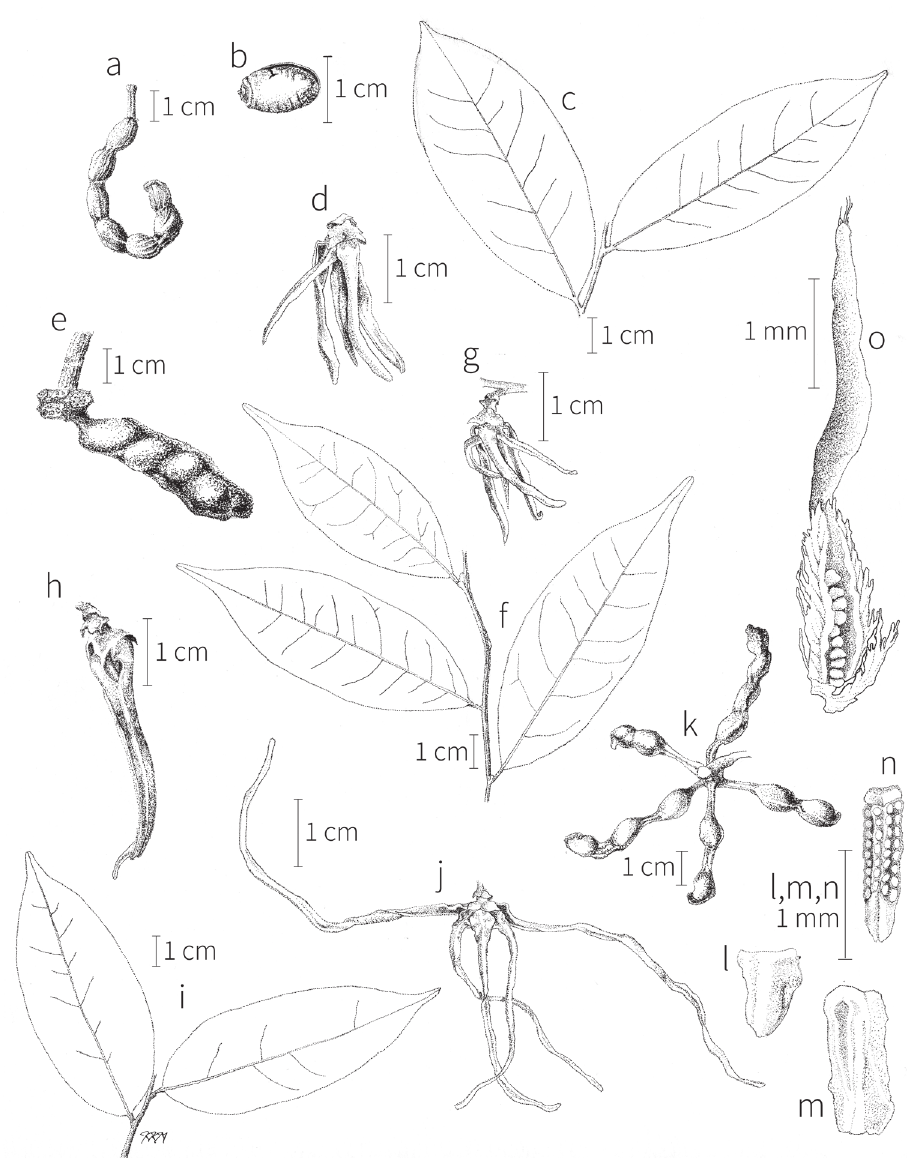
Figure 33. Xylopia unguiculata, X. acutiflora , and X. piratae . A–D, L–O X. unguiculata A Monocarp, lateral view B Seed C Leaves D Flower, lateral view L, M Staminodes, abaxial view N Stamen, abaxial view O Carpel, lateral view with ovary wall cut away to show arrangement of ovules E–G X. acutiflora E Monocarp, lateral view, attached to pedicel F Leaves G Flower, lateral view H–K X. piratae H Flower bud, lateral view I Leaves J Flower, lateral view K Fruit. A–B from Le Testu 1179 (BM) C–D from Reitsma & Reitsma 1923 (NY) E–G from Beentje 879 (WAG) H–J from de Koning 4999 (WAG) K from de Wilde 356 (P) L–O from McPherson 16960A